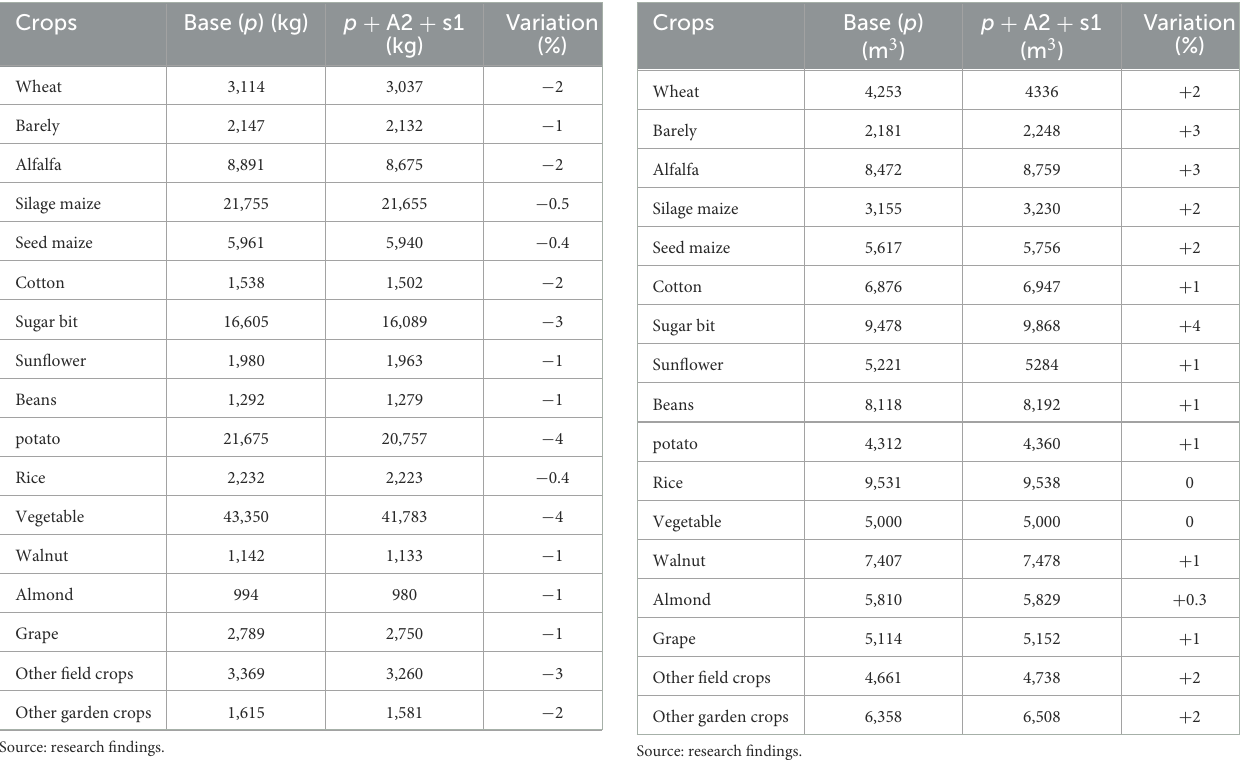
TABLE 2 The results of crop yield simulation. TABLE 3 The result of the simulation of net water requirement.